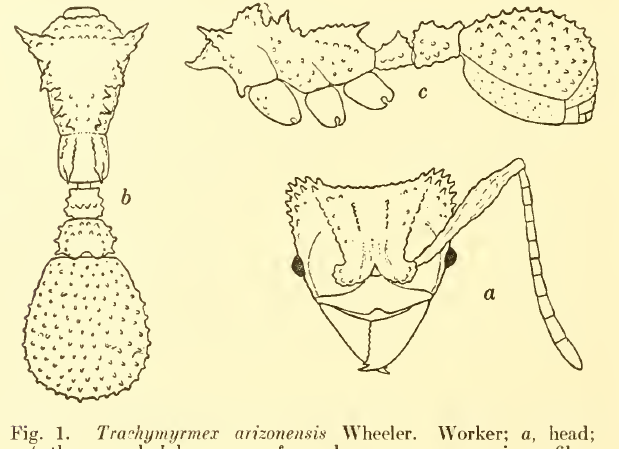
Fig. 1. Trachymyrmex arizonensis Wheeler. Worker; a, head; 6, thorax and abdomen seen from above; c, same seen in profile. base and declivity, the latter sloping, the former flattened and bearing a pair of longitudinal ridges which diverge slightly behind and terminate in the spines. These are acute and rather slender, a little longer than broad at their bases, directed outward and backward and but very slightly upward. Petiole with a narrow and very short peduncle; its node with a bitubercular summit, seen from above as long as broad, rounded behind, with parallel sides; in profile it is acutely angular, with straight anterior and posterior declivities, the former a little longer than the latter. Postpetiole nearly twice as broad as the petiole, broader behind than in front; its posterior border with a rounded lobe on each side and a rounded excision in the middle. Its upper surface is distinctly concave behind, so that in profile it is highest in front, with a short, straight anterior and a somewhat longer, concave posterior slope. Gaster oval, slightly broadest behind the middle, its first segment with